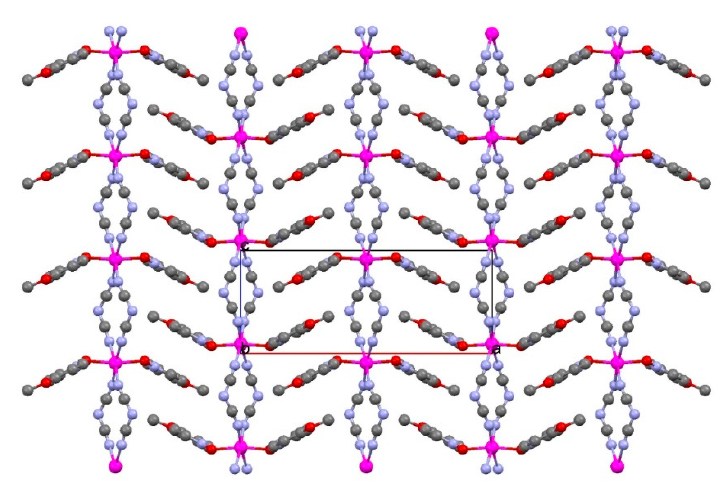
Figure 2. ( top ) One dimensional (1D) chain system of 2 . Symmetry operations: (’) 1-x,1-y,-z; (”) 1-x,1-y,1-z; (*) x,y,-1 + z; ( bottom ) packing plot of 2 .